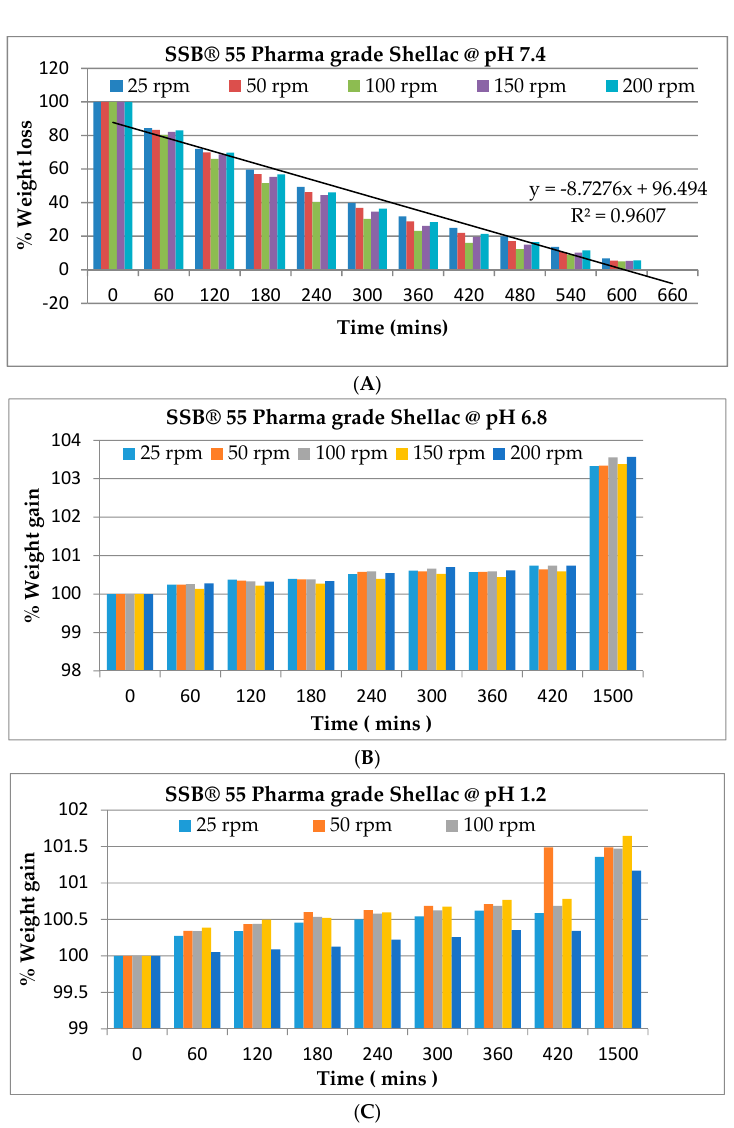
Figure 12. Plots of % weight gain/loss over time in ( A ) pH 7.4; ( B ) pH 6.8 and ( C ) pH 1.2.